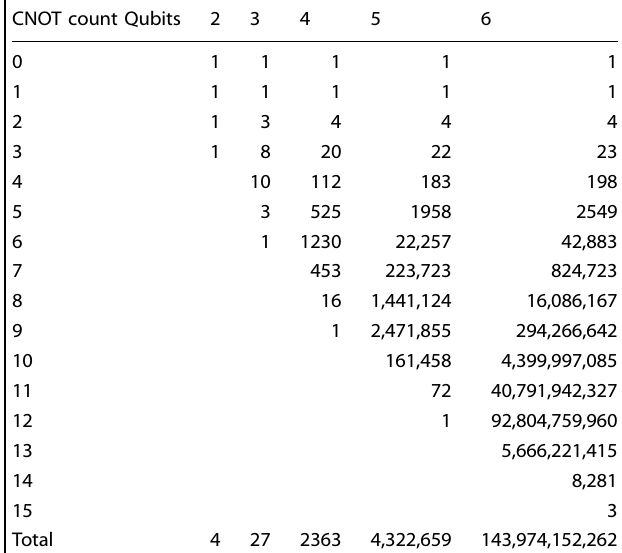
Table 6. The distribution of the number of equivalence classes across Clifford circuits over 2, 3, 4, 5, and 6